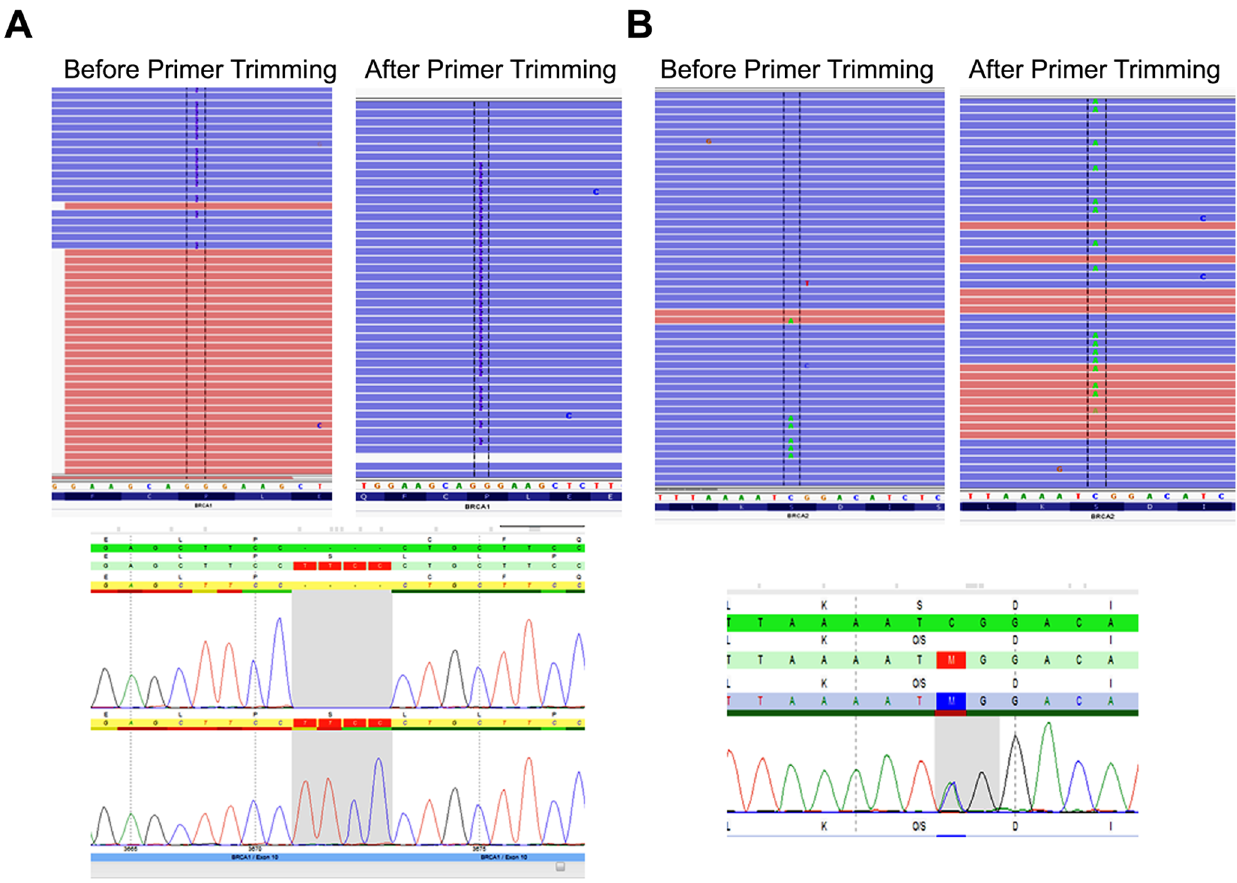
Figure 3. Primer sequence trimming increases detection sensitivity. Two heterozygous causative variants A) BRCA1 c.3671_3672insCTTC and B) BRCA2 c.2918C . A that were missed without primer trimming were detected with the function enabled in the pipeline. Both calls were confirmed with Sanger sequencing.